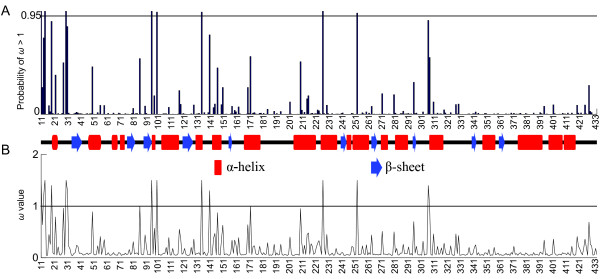
Estimated parameters under the M8 model using Selecton web-server. Approximate posterior means of ω are weighted by the posterior probabilities. Sites are numbered according to the reference sequence from Taxus mairei (GenBank accession number: AY450856).